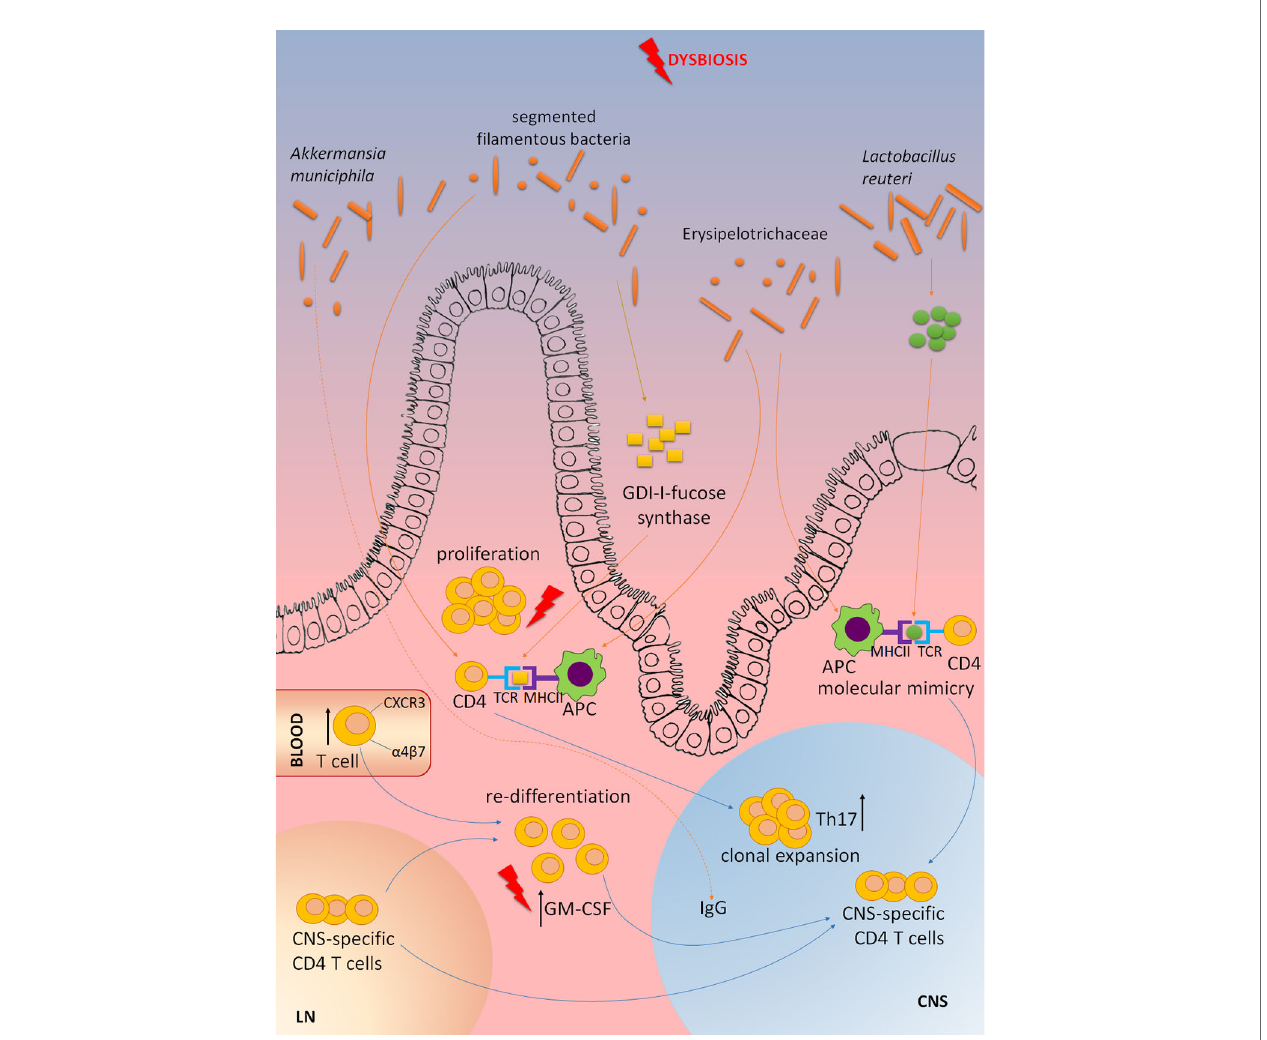
FIGURE 3 | The contribution of gut microbiota dysbiosis to MS pathogenesis. Elevated levels of Akkermansia muciniphila -speci fi c IgG are present in the cerebrospinal fl uid of MS patients. CD4 + T cell clone that is clonally expanded in MS brain lesions is shown to recognize GDP-l-fucose synthase, an enzyme expressed by gut microorganisms. Peptides originating from Lactobacillus reuteri mimic myelin oligodendrocyte glycoprotein (MOG), while Erysipelotrichaceae can act as an adjuvant to enhance activity of antigen-presenting cells (APC), and subsequent activation of encephalitogenic Th17 cells. Segmented fi lamentous bacteria stimulate CNS autoimmunity by inducing Th17 cell differentiation. Dysbiosis of gut microbiota in MS patients correlates with increased abundance of CXCR3 + T cells expressing the gut-homing a 4 b 7 integrin receptor in the peripheral blood. Gut dysbiosis might increase the abundance of GM-CSF-producing CD4 + T cells that are among the major culprits in CNS autoimmunity. CNS-speci fi c T cells originating in lymph nodes (LN) migrate to the gut where they can undergo re-differentiation into potent encephalitogenic cells under the in fl uence of gut microbiota